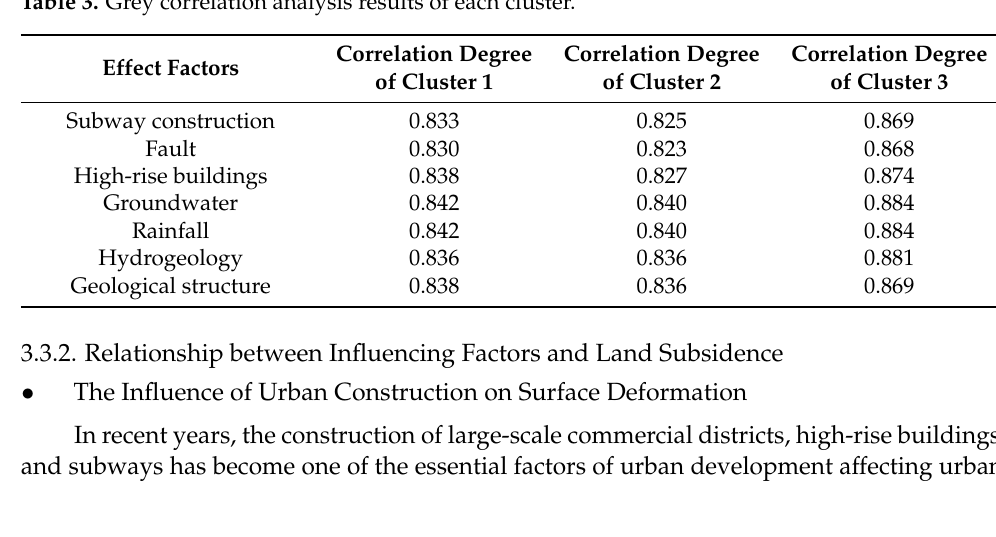
Table 3. Grey correlation analysis results of each